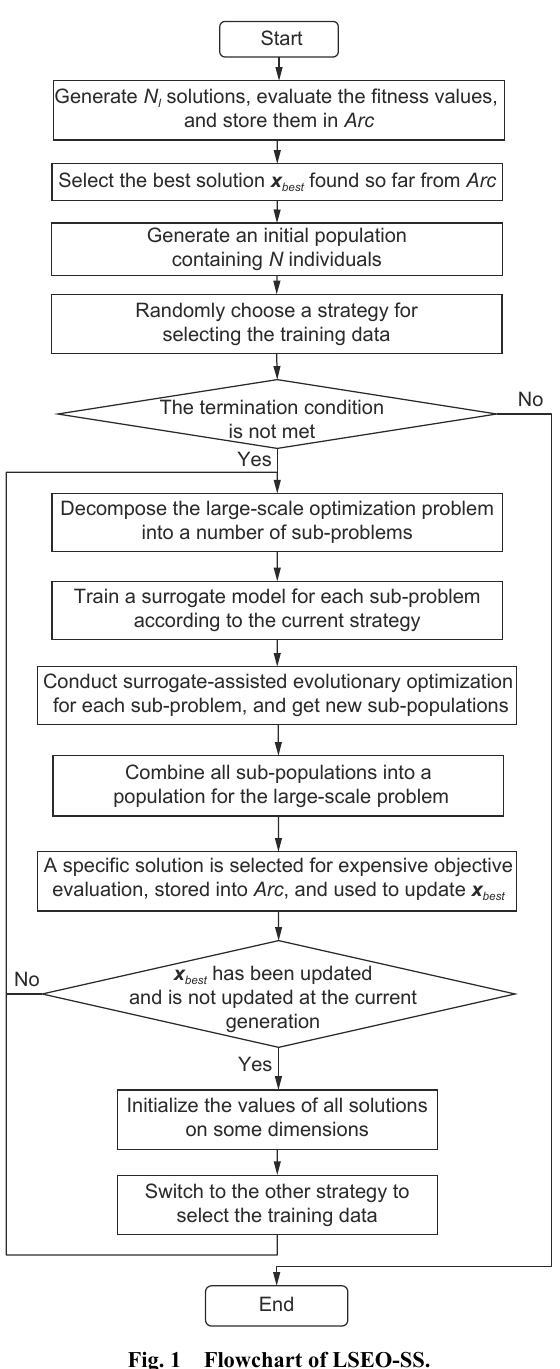
Fig. 1 Flowchart of LSEO-SS.